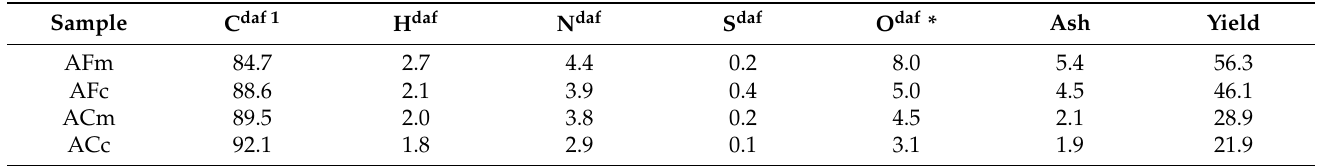
Table 1. Elemental analysis of the biocarbons obtained and the yield of activation processes